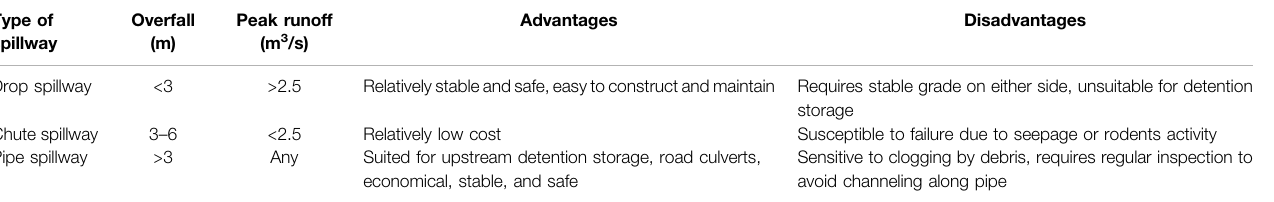
TABLE 2 | Suitability of different spillways as gully head control structure (Shit et al., 2020). Type of Overfall spillway